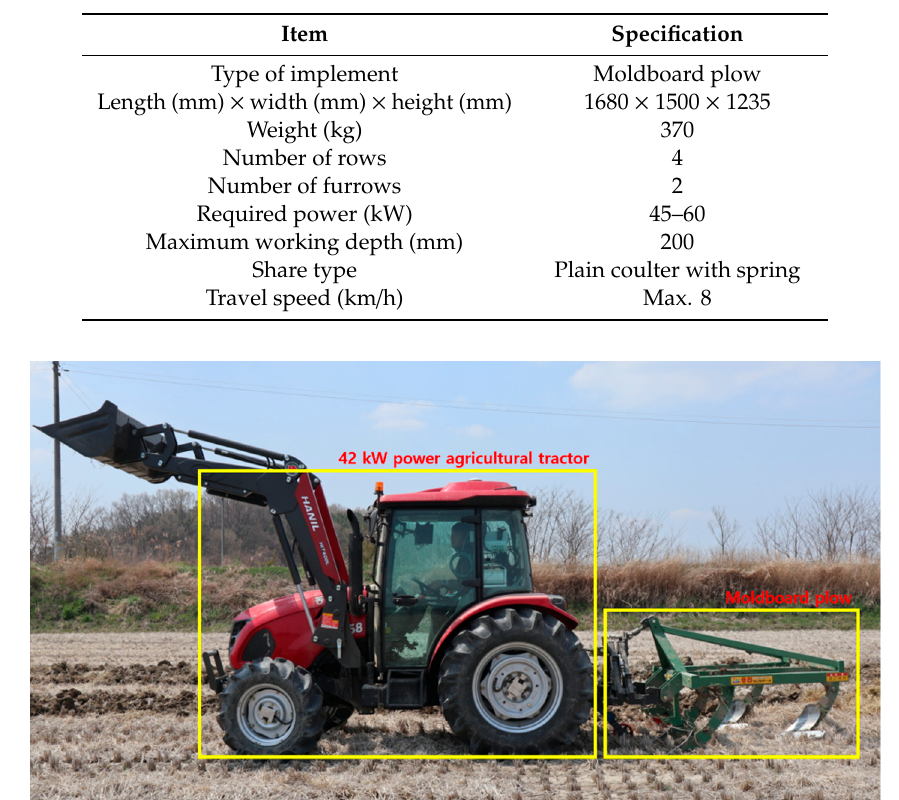
Table 2. Specifications of the plowing implement.